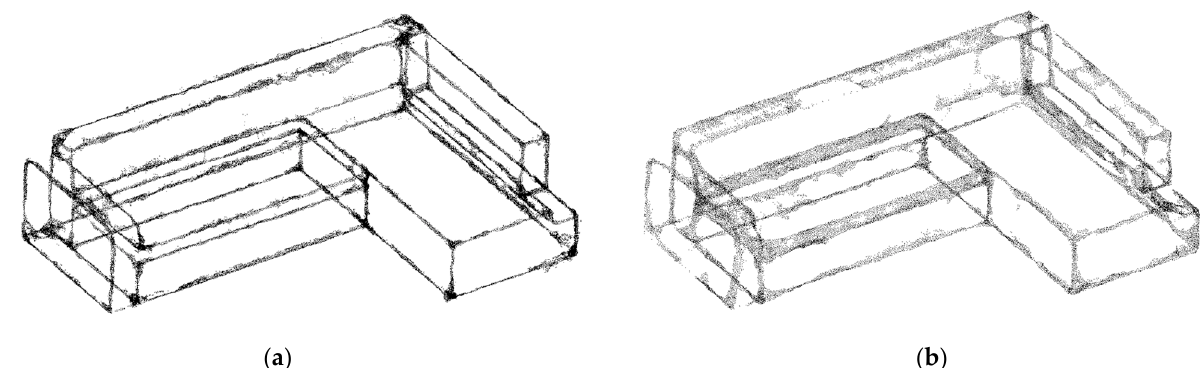
Figure 11. Ablation study on point feature extraction module. ( a ) shows the upsampling result using only local features, and ( b ) shows the upsampling result using only global features.